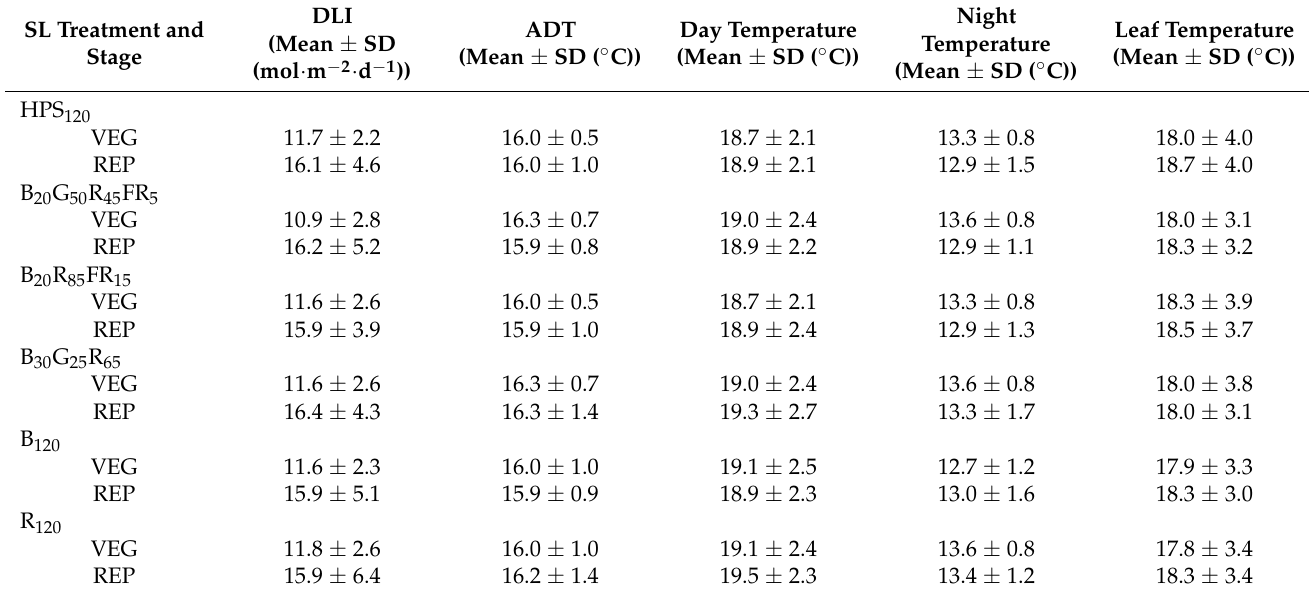
Table 2. Actual daily light integrals (DLIs) (mean ± SD (mol · m − 2 · d − 1 )), average daily temperatures (ADTs), mean day temperature, mean night temperature, and mean leaf temperature (mean ± SD ( ◦ C)) for each supplemental light (SL) treatment during the vegetative (VEG) and reproductive (REP) stages of replication 2. SL treatments consisted of either 460 W high-pressure sodium fixtures (HPS 120 ; LR48877; P.L. Light Systems, Beamsville, ON, Canada), 631 W light-emitting diode (LED) fixtures (B 20 G 50 R 45 FR 5 ; VYPR 2p; Fluence, Austin, TX, USA), 325 W LED fixtures (B 20 R 85 FR 15 ; LumiGrow Pro 325; LumiGrow, Emeryville, CA, USA), 600 W LED fixtures (B 30 G 25 R 65 ; LX601G, Heliospectra, Göteborg, Sweden), a combination of 72 W LED fixtures (B 120 ; HortiLED MULTI, P.L. Light Systems) and 625 W LED fixtures (R 120 ; LumiGrow Pro 650E, LumiGrow), or 625 W LED fixtures (LumiGrow Pro 650E; LumiGrow).